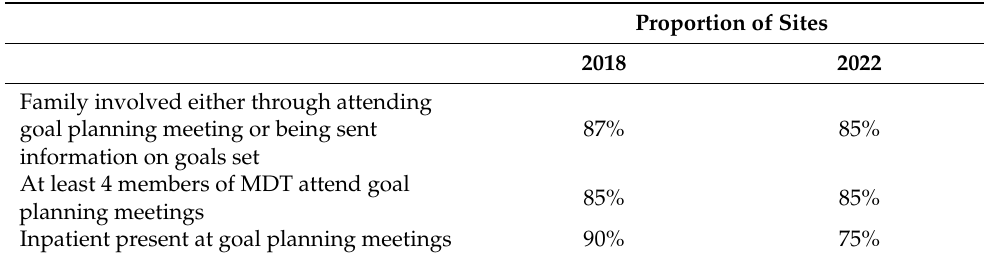
Table 7. Inpatient, family and MDT participation in goal planning across sites in 2018 and 2022 for adult inpatients.